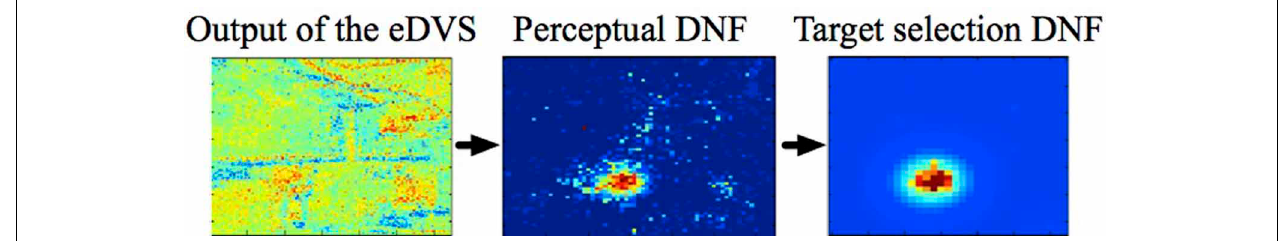
FIGURE 5 | The cascade from the visual input to perceptual DNF to the visual intention (target) DNF segregates and stabilizes the selected region in the input